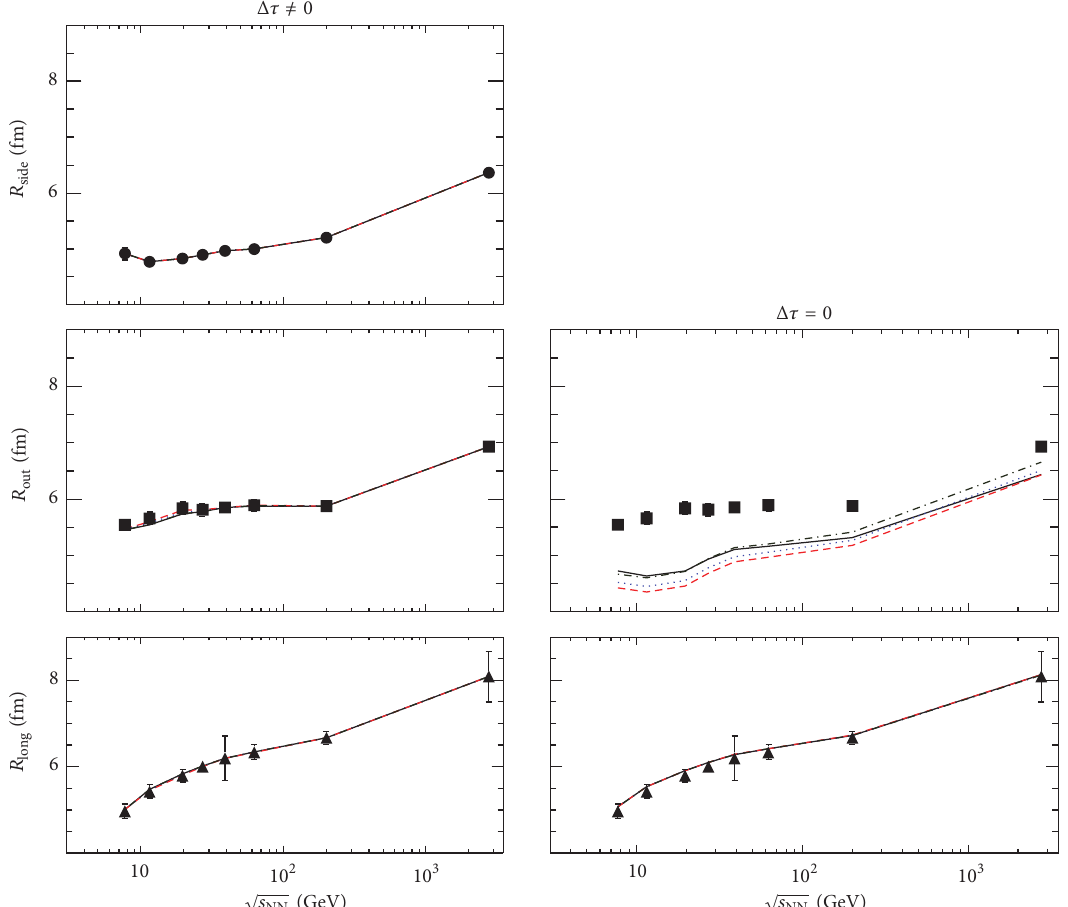
Figure 4: The extracted values of 𝑅 kinetic temperature parametrisation. Markers are experimental data from [20, 39]. Left panels are results with finite particle emission duration ( Δ𝜏 ) and right panels for the cases of Δ𝜏 = 0 .